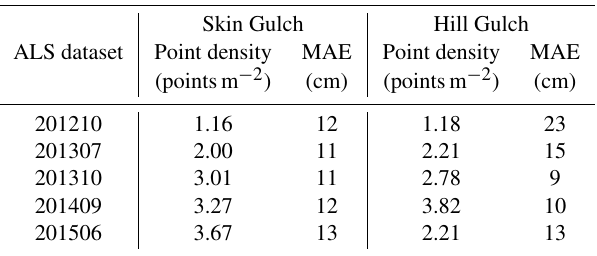
Table 3. Point density and average mean absolute error (MAE) for each ALS dataset for Skin Gulch and Hill Gulch, respectively. MAE was determined by the elevation difference between total station and RTK-GNSS survey points and interpolated ALS